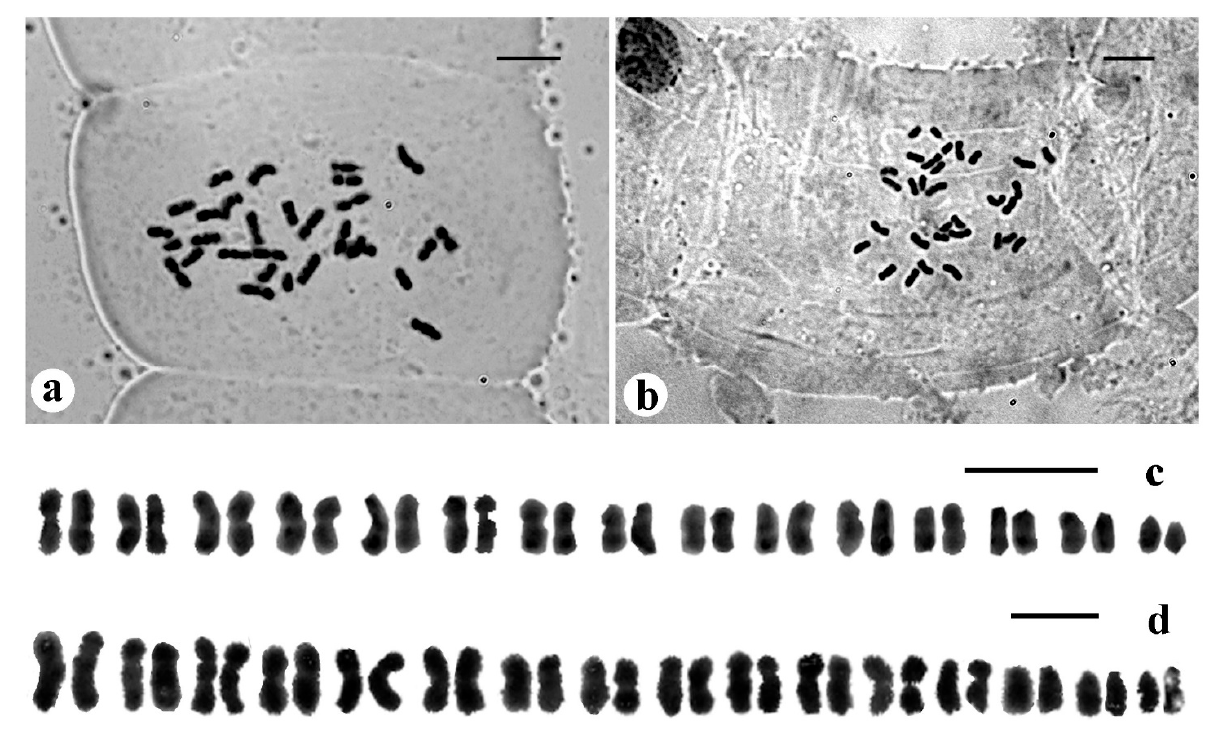
Figure 4. Mitotic metaphase chromosomes and karyograms. ( a ) and ( c ) show Bentinckia condapanna (2 n = 30); ( b ) and ( d ) show B. nicobarica (2 n = 32). Scale bars = 5 μ m. (2 n = 30); ( b ) and ( d ) show B. nicobarica (2 n = 32). Scale bars = 5 µ m. Table 1. Comparative karyotypes of Bentinckia condapanna and B. nicobarica